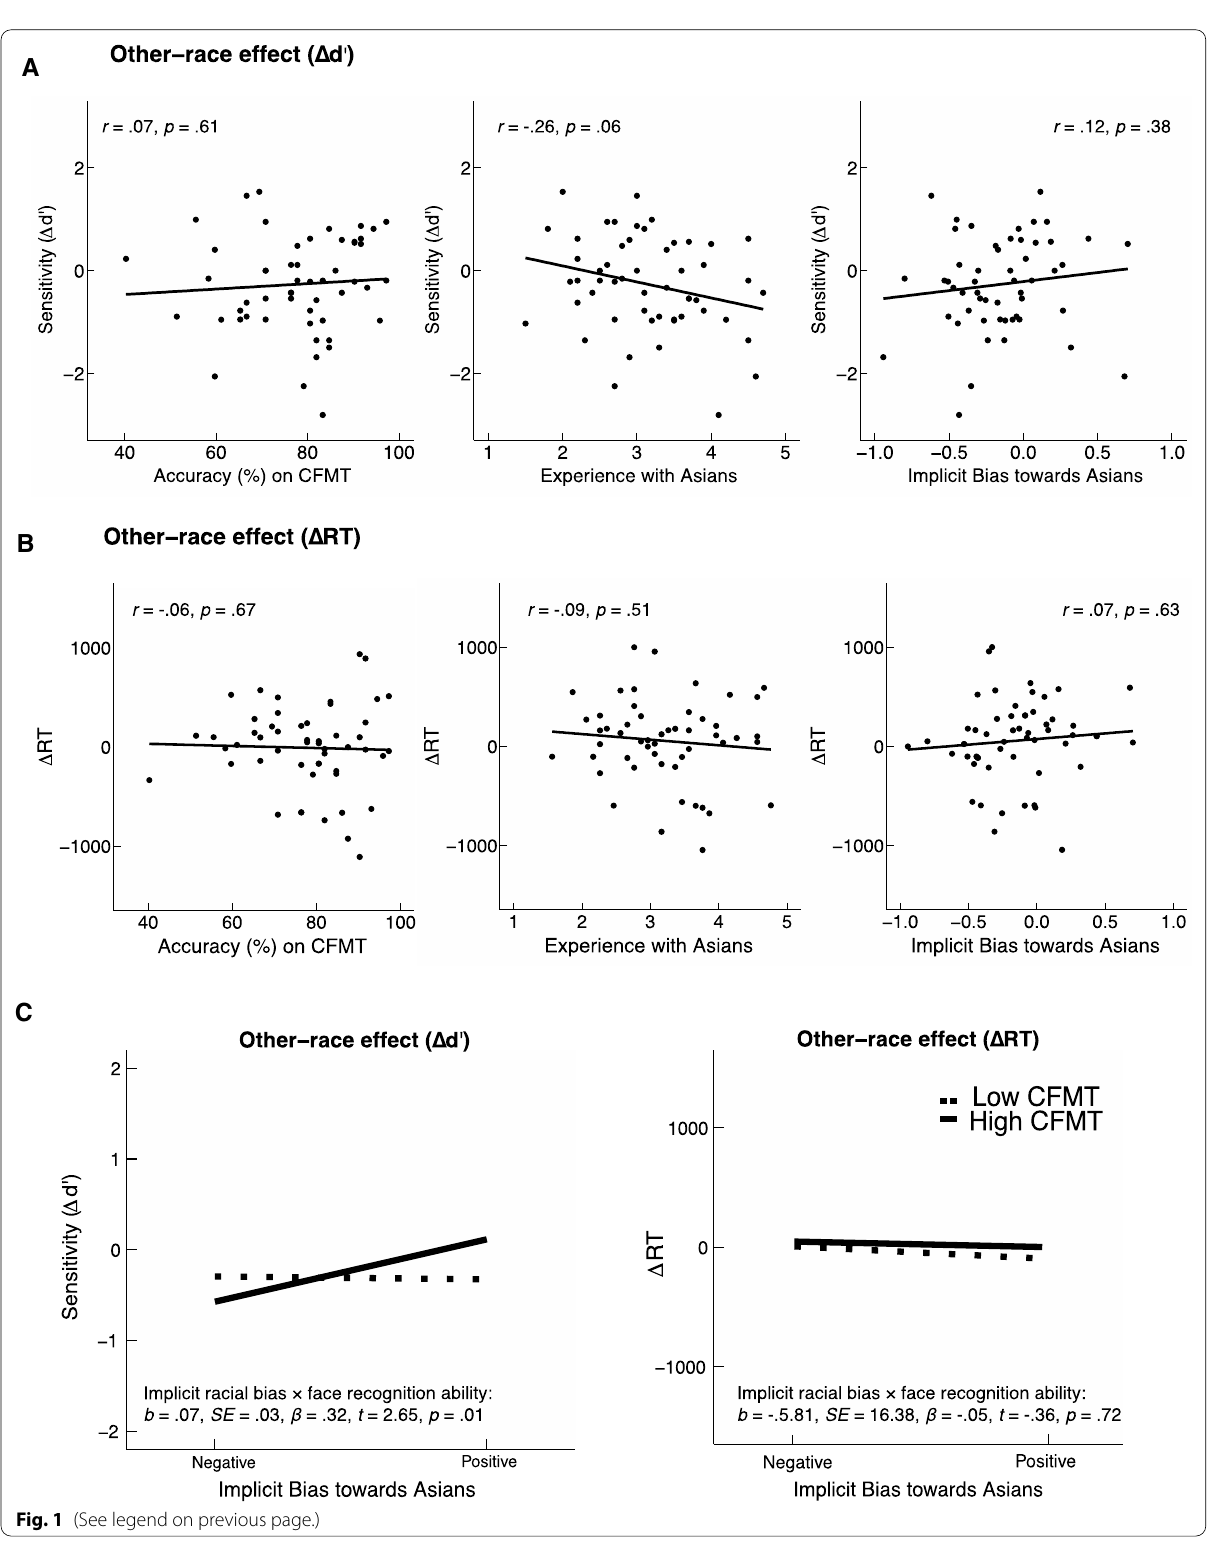
Fig. 1 (See legend on previous